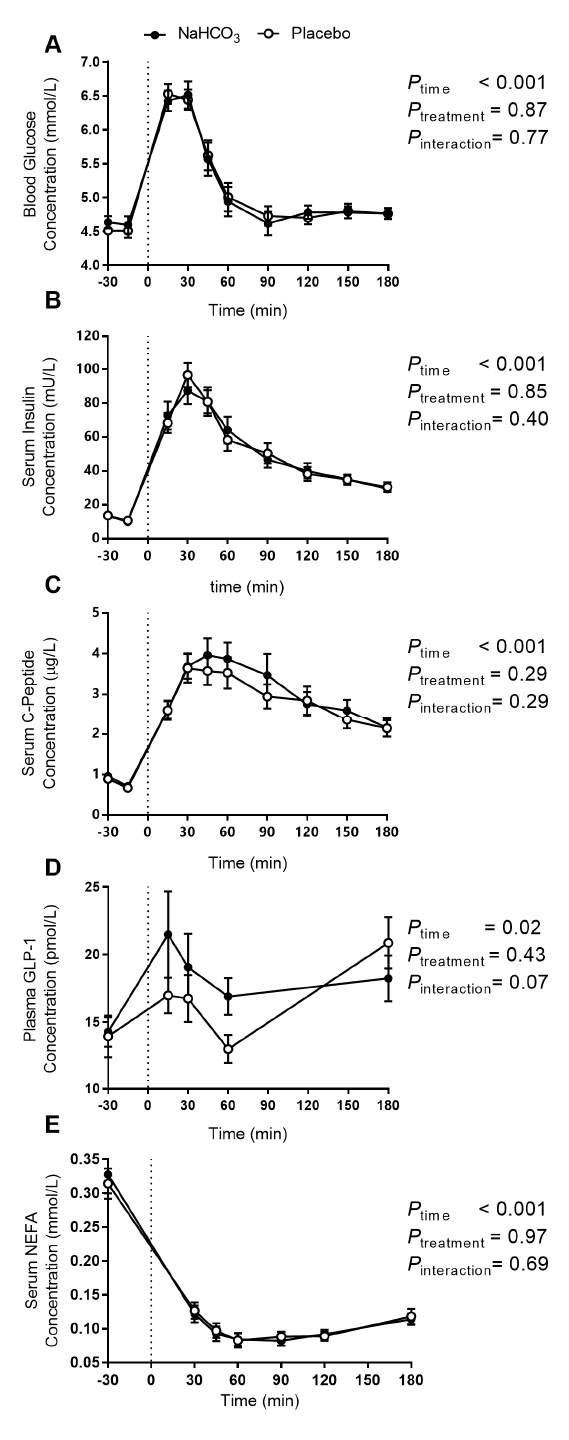
Figure 4. The effect of oral NaHCO 3 (1680 mg) administered prior to a high acid load meal on blood glucose ( A ); serum insulin ( B ); serum C -peptide ( C ); plasma GLP-1 ( D ); and serum NEFA ( E ); comparing NaHCO 3 (solid circle) and placebo (hollow circle). Treatment was administered at t = − 30 min and the meal was completed at t = 0 (indicated by a dotted line). The effect of the treatment versus placebo on the postprandial outcome measure was tested by two-way repeated measure ANOVA, with p -values indicated on the graphs. All data presented as mean ± SEM. Abbreviations: GLP-1, glucagon-like peptide 1; NEFA, non-esterified fatty acids.